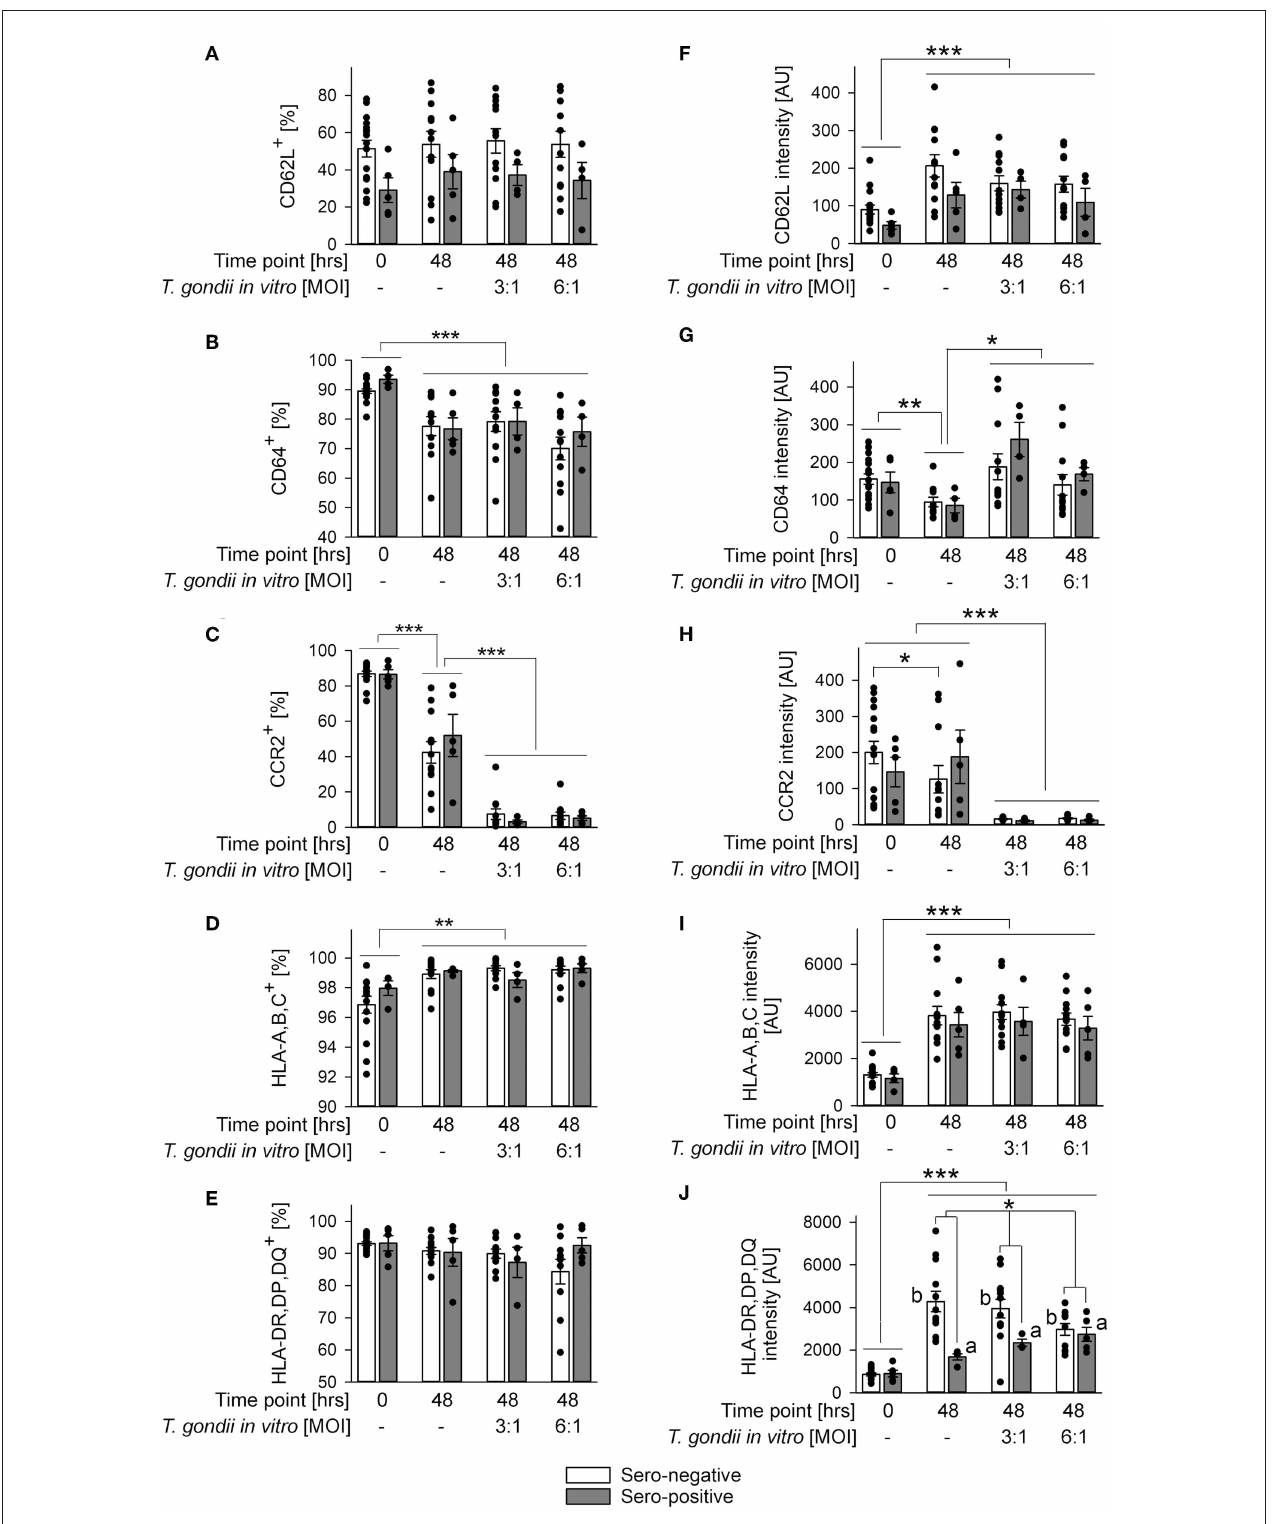
FIGURE 4 | Impact of in vitro infection of monocyte-enriched PBMCs with T. gondii on expression of CD62L, CD64, CCR2, HLA-A,B,C, or HLA-DR,DP,DQ on monocytes from donors with or without chronic toxoplasmosis. Monocyte-enriched PBMCs were isolated from blood samples and were either directly FACS-analyzed